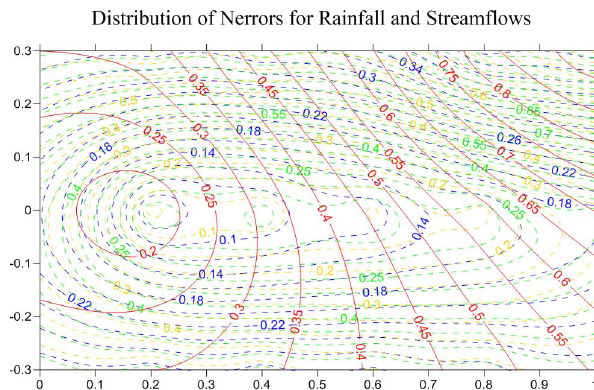
Fig. 4. Normalised errors distribution of perturbed rainfall and stream flow (red solid line: rainfall, orange dot line: MIKE SHE, green dot line: TOPMODEL, blue dot line: